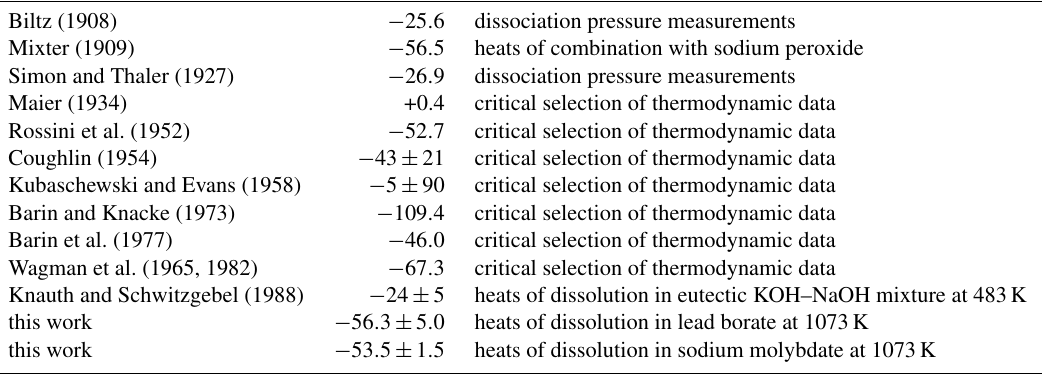
Table 7. Enthalpies for reaction 0.5Sb 2 O 3 (valentinite) + 0.5Sb 2 O 5 → Sb 2 O 4 (Eq. 27) at T = 298 . 15K. All data are in kJmol − 1 .